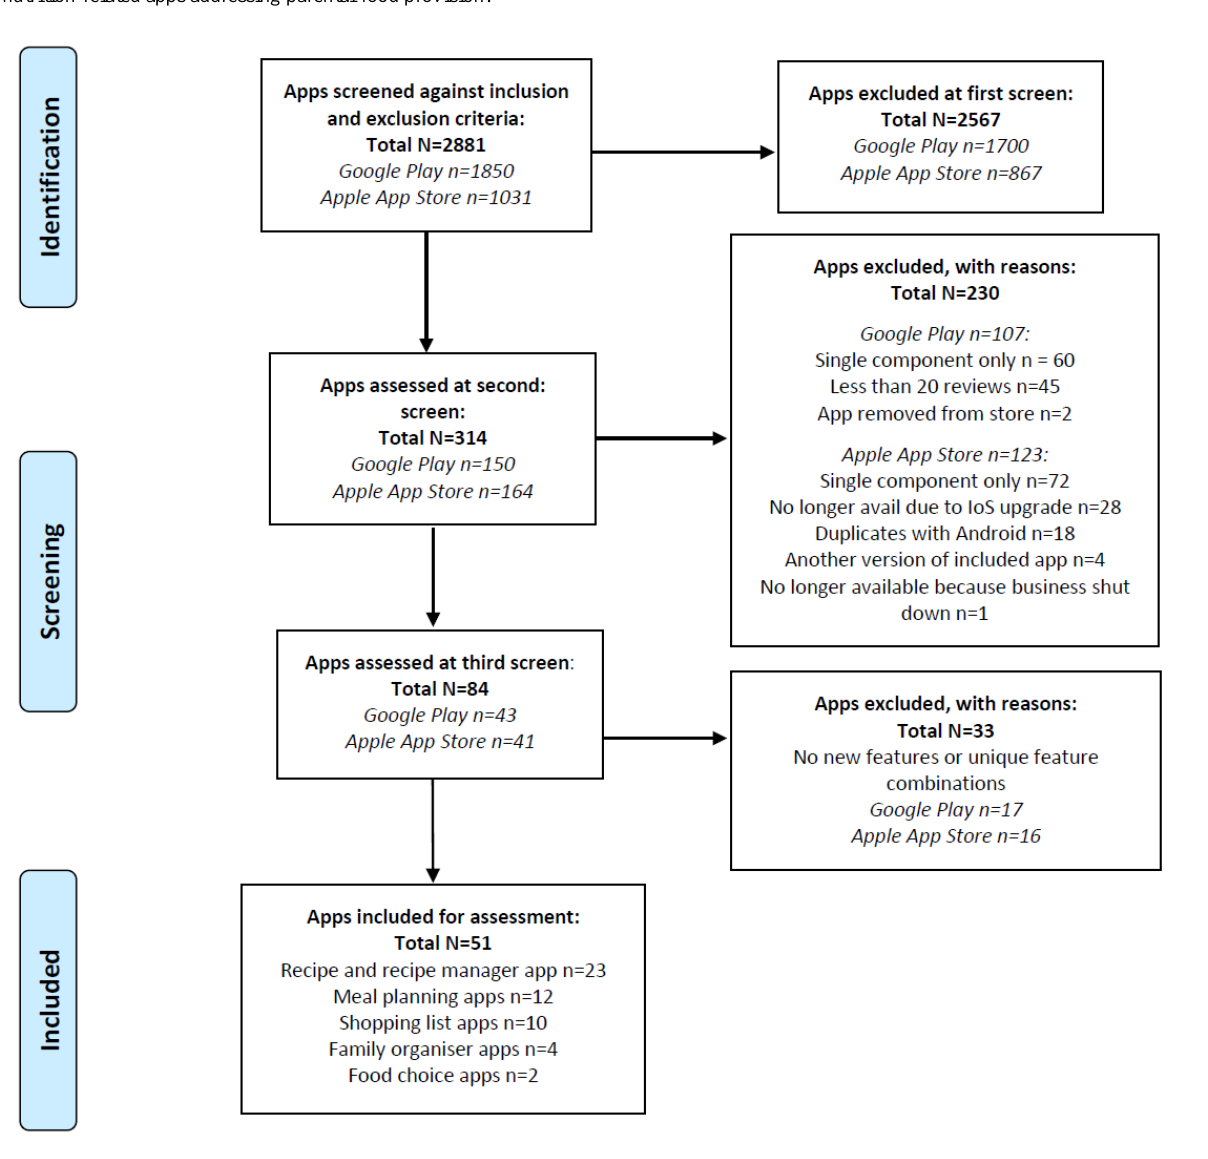
Figure 1. PRISMA (Preferred Reporting Items for Systematic Reviews and Meta-Analyses) flow diagram for popular, commercially available food and nutrition-related apps addressing parental food provision.